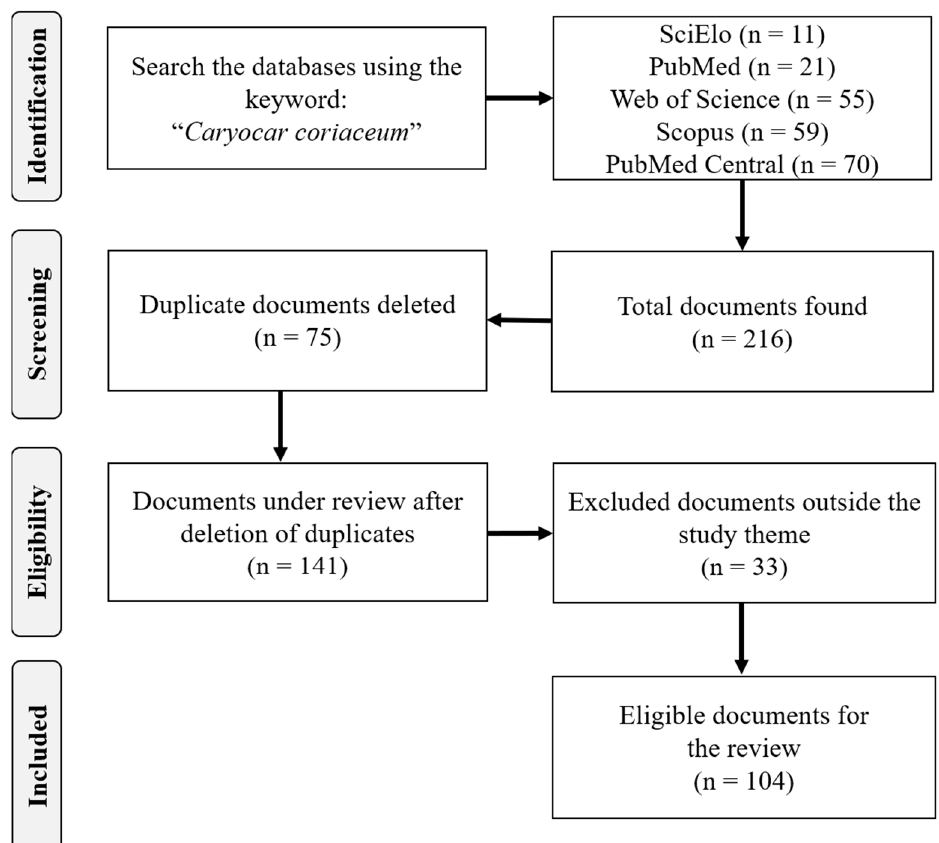
Figure 5. Flowchart describing the search and selection strategies.